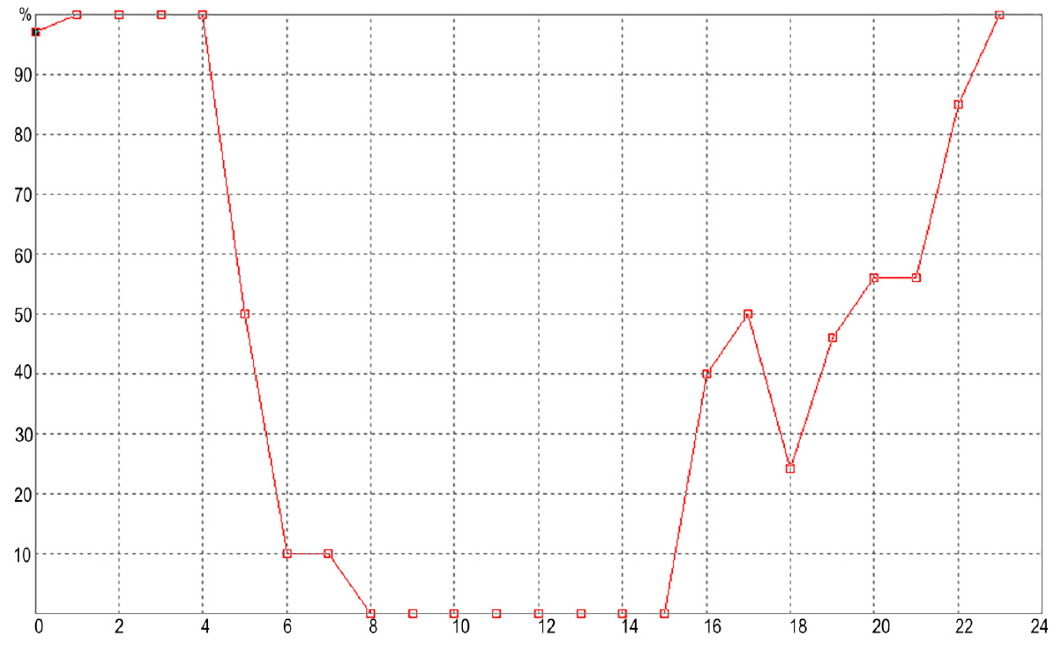
Figure 14. Room Figure 14. Room schedule. Figure 14. Room schedule.